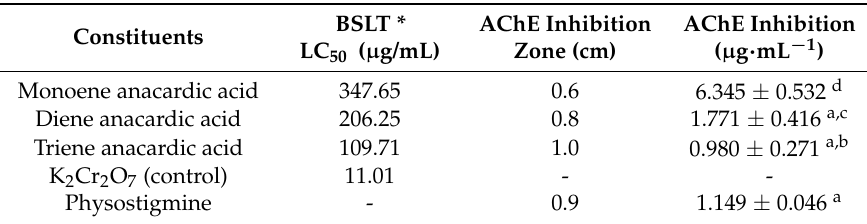
Table 3. Biological activities of anacardic acids from Brazilian CNSL in brine shrimp lethality and acetylcholinesterase (AChE) inhibition